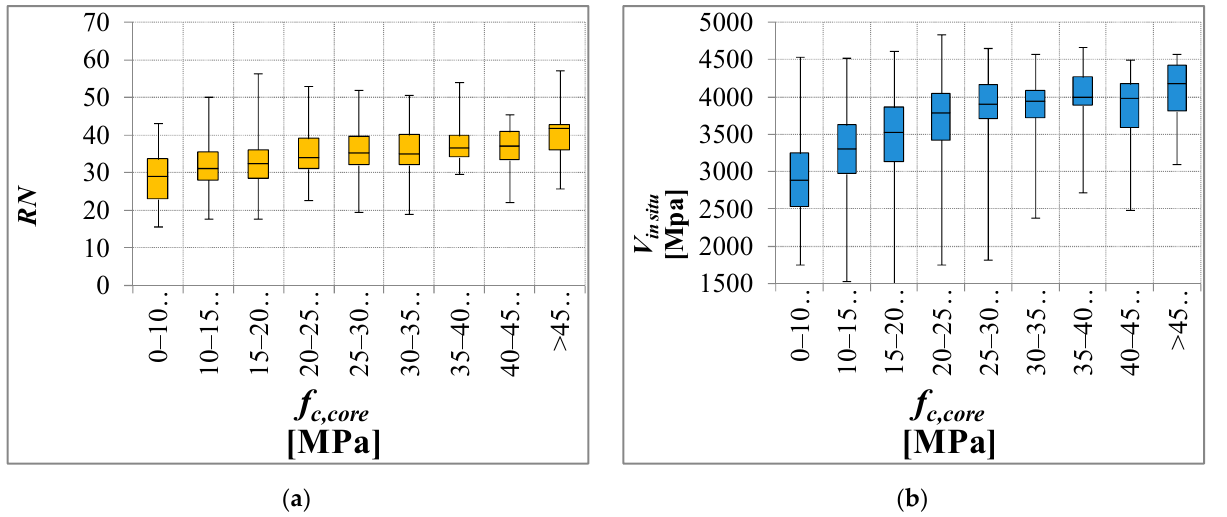
different age of concrete based on the design code and available data.